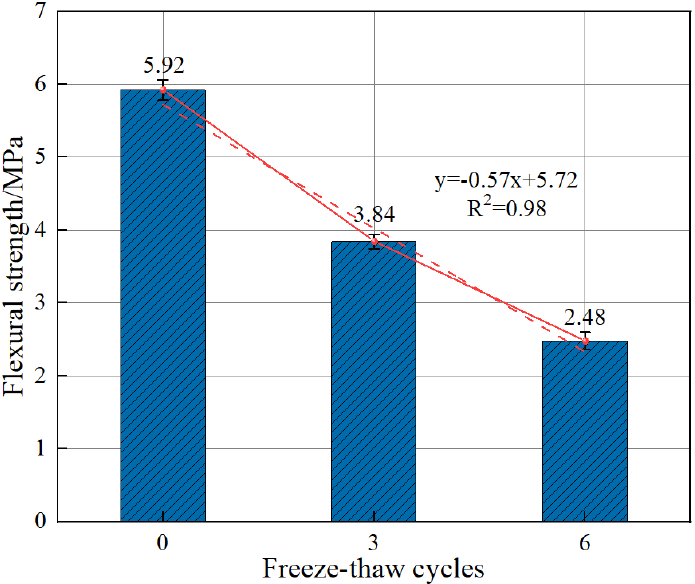
Figure 21. Effect of the number of freeze–thaw cycles on the flexural strength of BFRC.